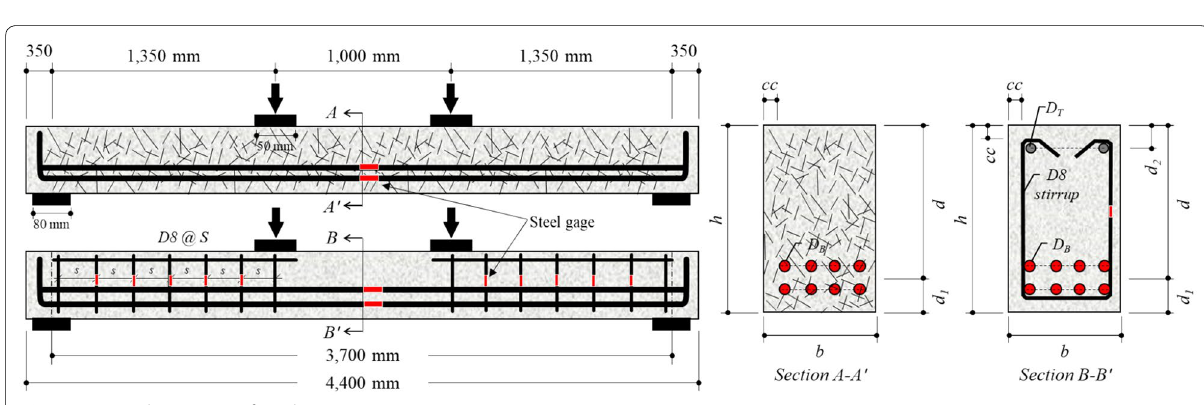
Fig. 3 Sectional geometry of test beams.